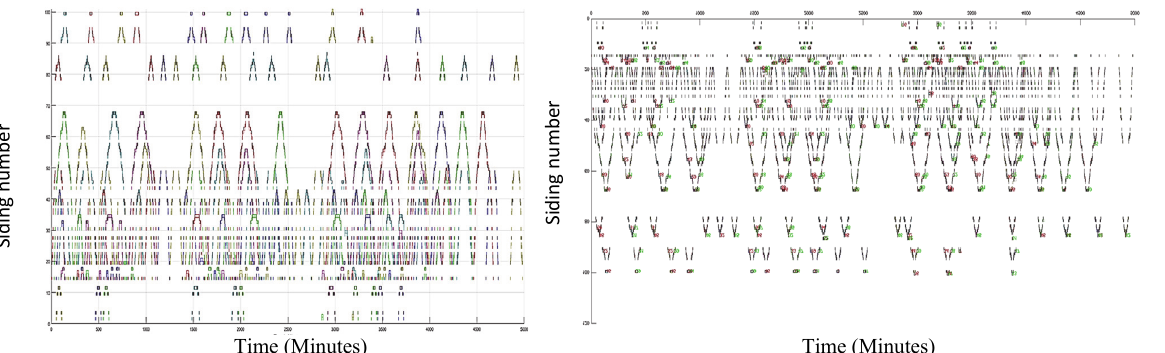
Fig. 11. Gantt chart of 6 trains scheduling with Fig. 12. Delivery and collections at marked sidings within